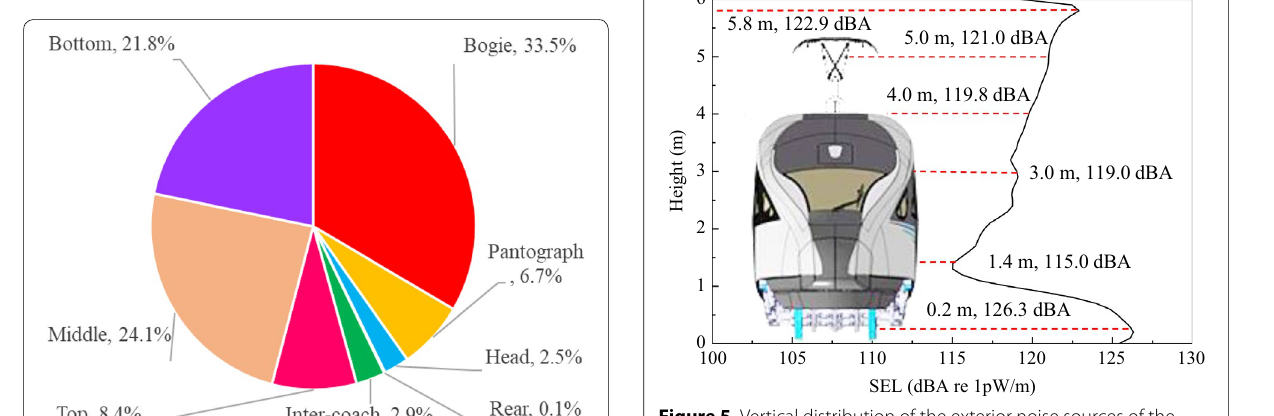
Figure 5 Vertical distribution of the exterior noise sources of the high-speed train running at 310 km/h (frequency range: 500– 5000